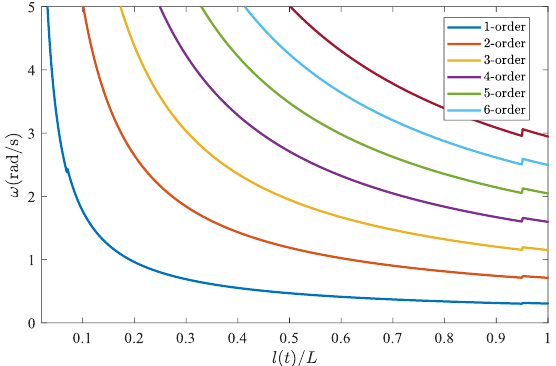
Figure 3. Transversal system frequency.